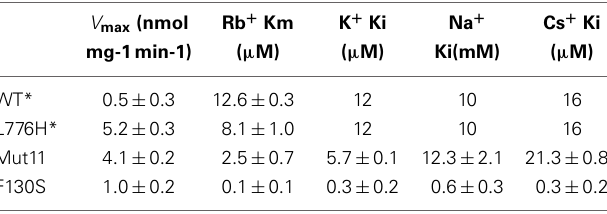
Table 2 | Kinetic parameters of Rb + uptake mediated by AtHAK5 and its mutant forms in yeast.